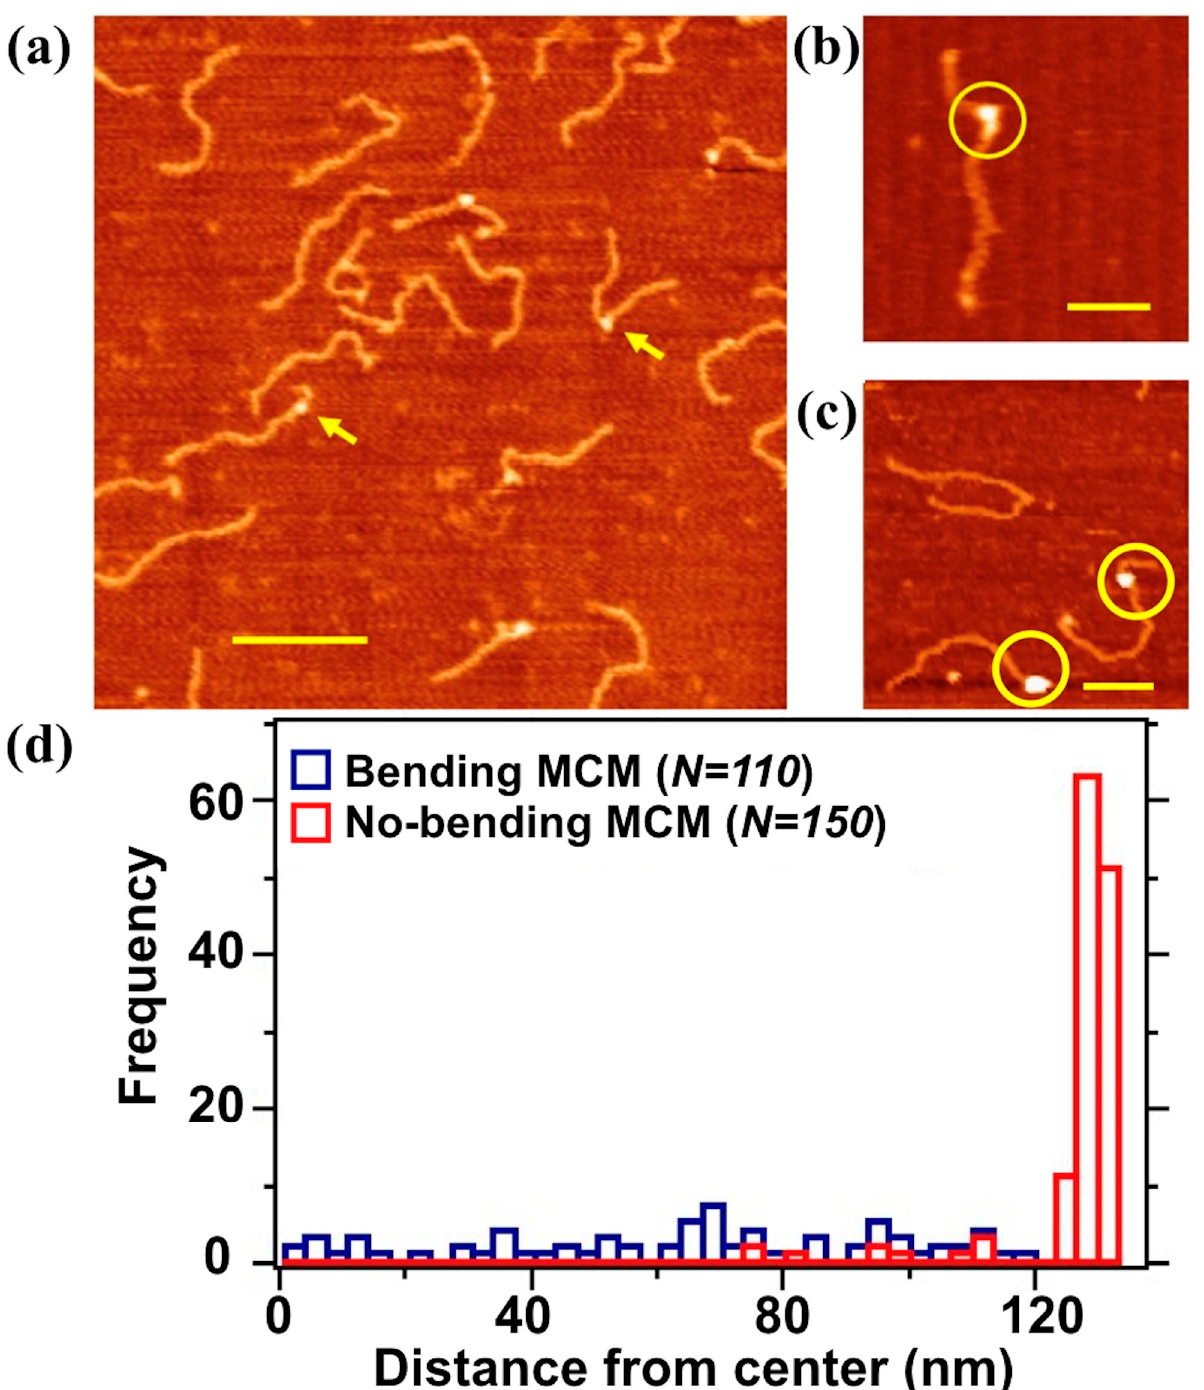
Figure 3. Representative non-contact AFM image of DNA–MCM complexes performed in air. ( a ) A solution containing 2 nM MCM proteins and 2 nM of 807 bp long DNA molecule was deposited on freshly cleaved mica. Scale bar 200 nm. The yellow arrows point to two different MCM–DNA topologies, in which MCM is either bound without changing the direction of the DNA or is creating a kink in the DNA conformation; these kinks are not observed in the AFM images of free DNA. Free DNA molecules that did not interacted with the MCM complex are also visible; ( b ) “bending” MCM: we observe a kink in the DNA induced by the presence of MCM; ( c ) “no bending” MCM: the MCM complex does not affect DNA conformation; and ( d ) distribution of the MCM position along the DNA in the “no bending” and “bending” conformations. MCM position is calculated from the middle of the DNA strand.